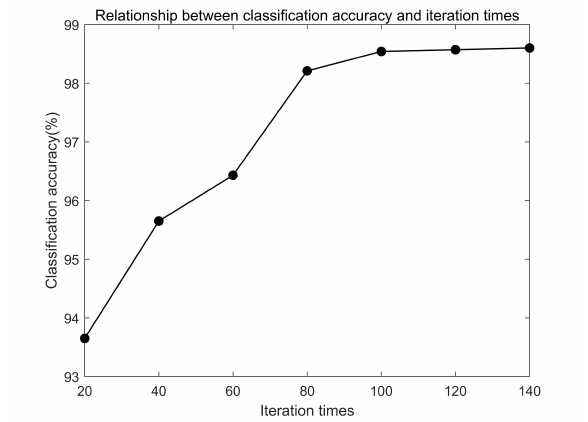
Figure 9. Relationship between classification accuracy and iteration